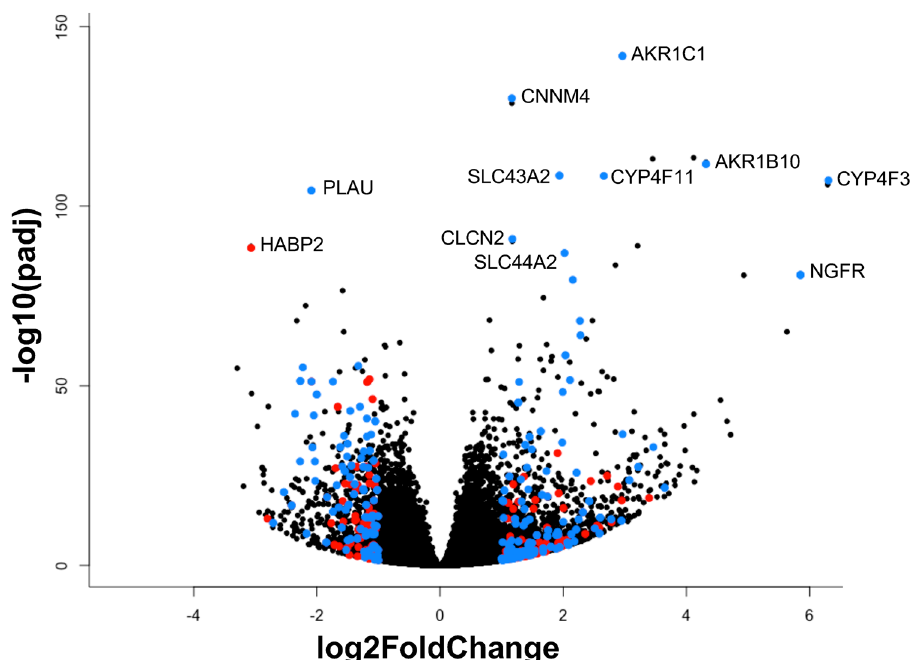
Figure 2. Volcano plot displaying differential expressed genes in samples under fluid shear stress conditions and static environment. The y-axis corresponds to the mean expression value of -log10 (padjust value), and the x-axis displays the log2 fold change value. Blue colored points represent most significant genes involved in kidney proximal tubule function. Red colored points represent GWAS (genome-wide association study) hits that denote inherited genetic variants associated with risk of renal diseases. Both subsets groups have padj equals < 0.05 and have a log2FC > ±